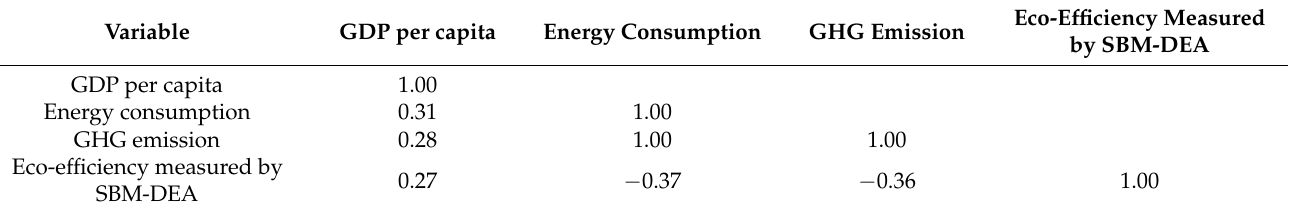
Table 7. Pearson’s correlation (r ) between eco-efficiency of road freight transport and GDP per capita in EU